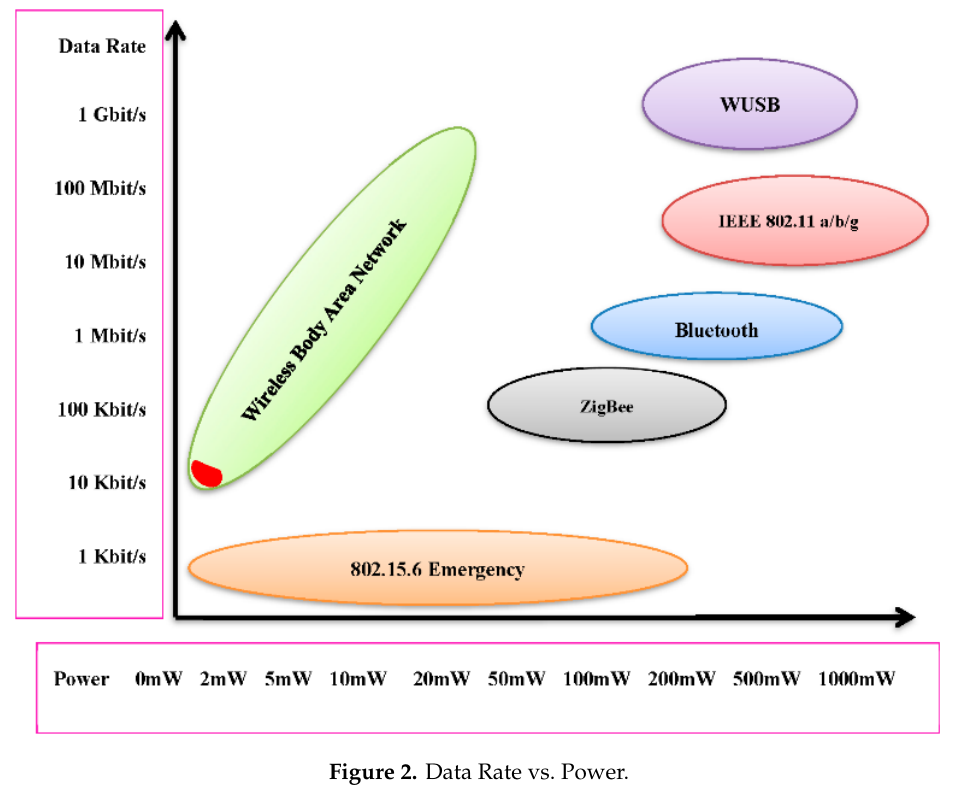
Figure 2. Data Rate vs. Power. Table 1. WBAN Application Operating Range